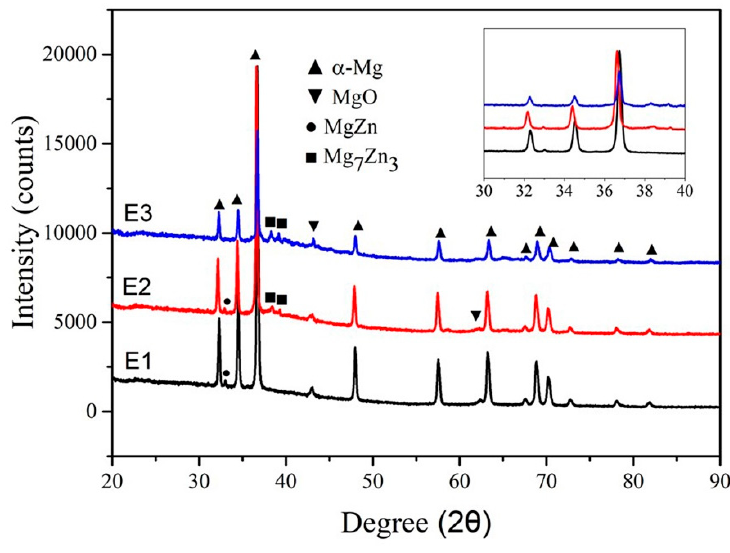
Figure 6. XRD patterns of the LAMed Mg-Zn-Zr alloys over 20–80°.